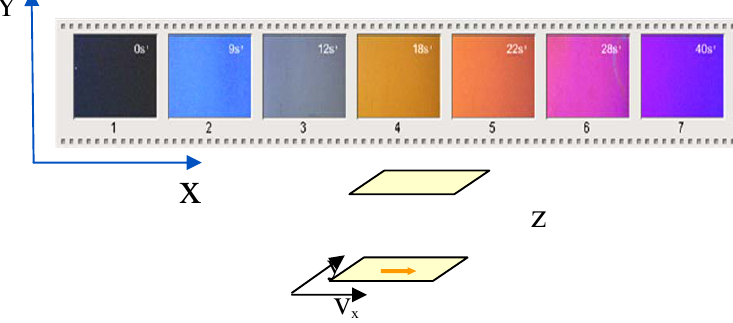
Figure 2. Snapshots of the isotropic phase of SCLCP. A strong birefringence appears over a critical shear rate. The colors (observed between cross-polarizers) indicate from left to right an increase of the birefringence. The photographs view the plane containing the velocity/vorticity axis (X,Y). (A movie of the shear-induced transition is available on: http://www.youtube.com/watch?v=igo9hpo8Tzo.) Bottom: scheme of the specific polymer conformation in the shear-induced phase. Mesogens and chain are parallel to the velocity axis